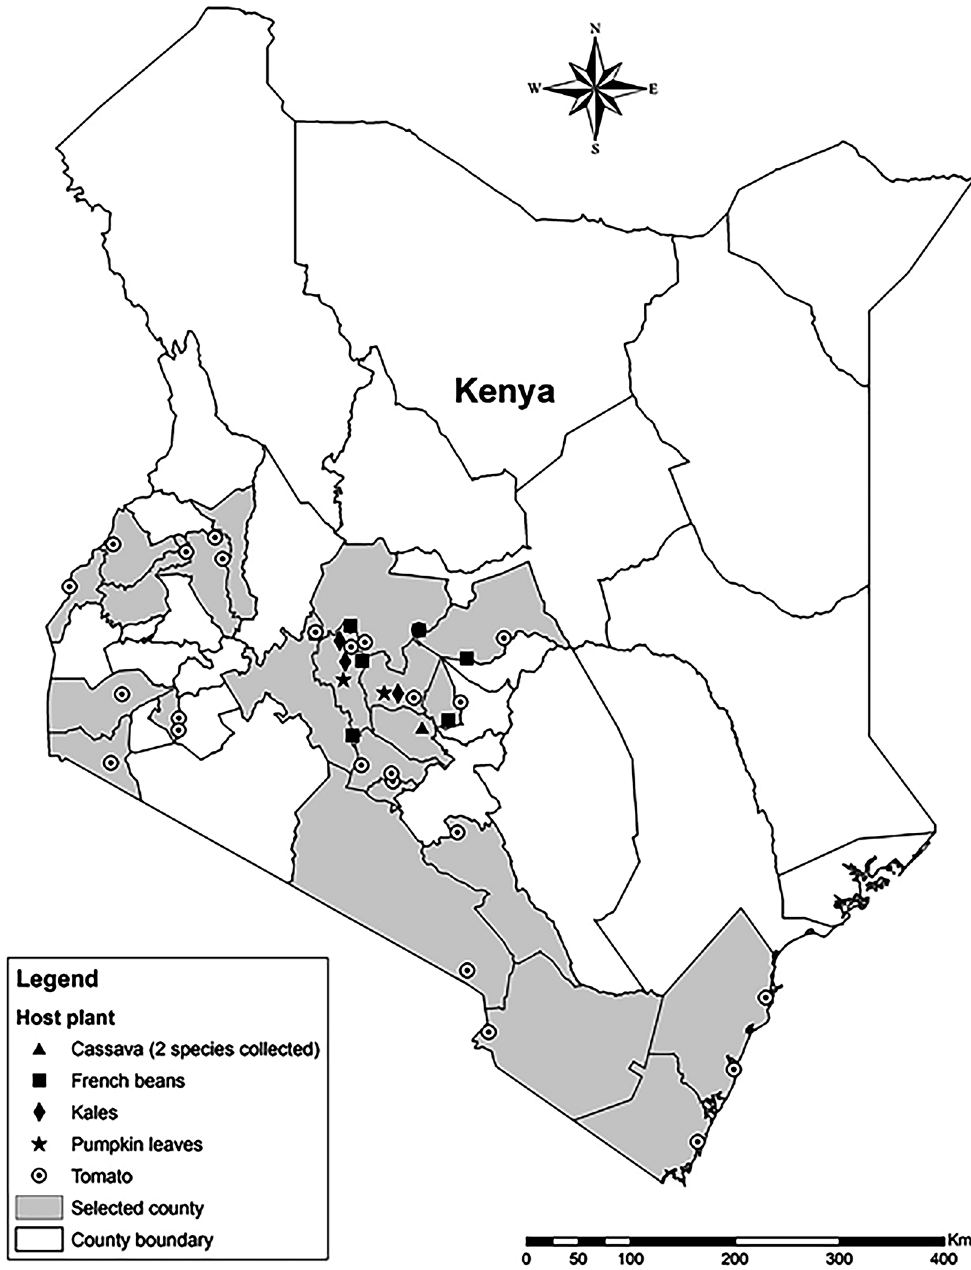
Figure 1. Distribution map of Trialeurodes vaporariorum in